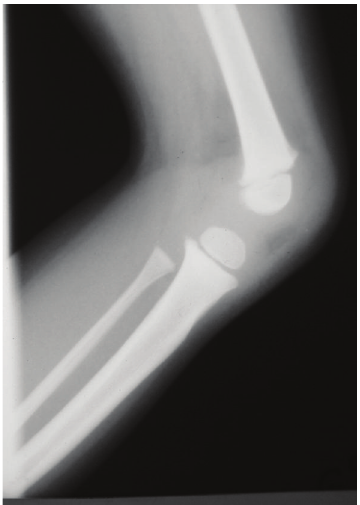
Figure 3: Hypoplasia and subluxation of the head of the